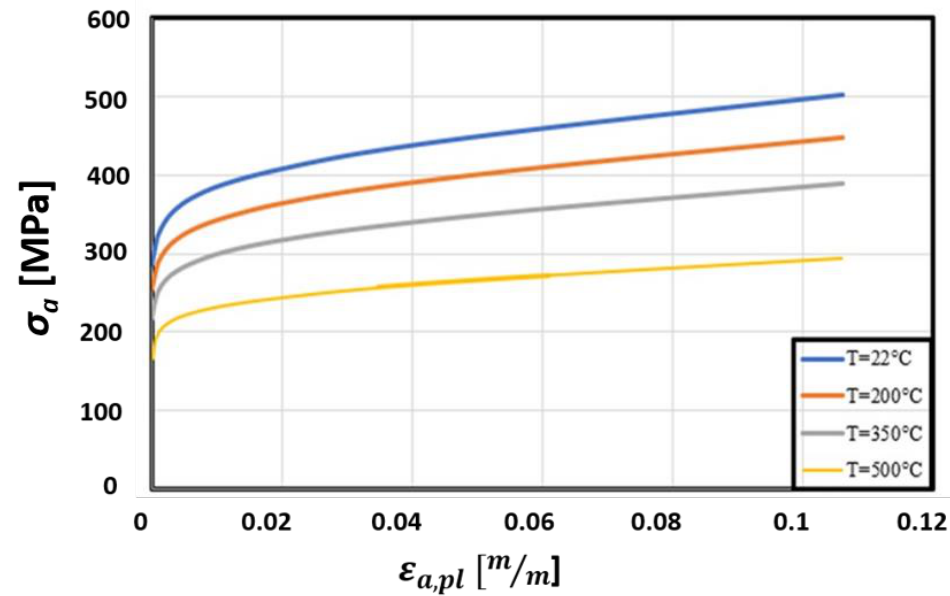
Figure 3. Temperature-dependent stress-strain curves for CuCrZr [16]. Figure 3